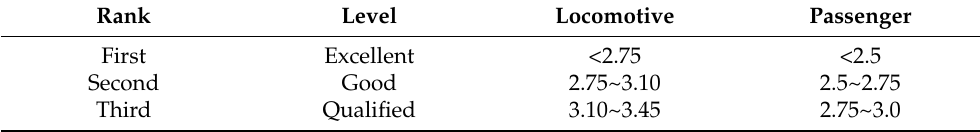
Table 4. The ranking criteria of the Sperling stability index W specified in China’s design code.